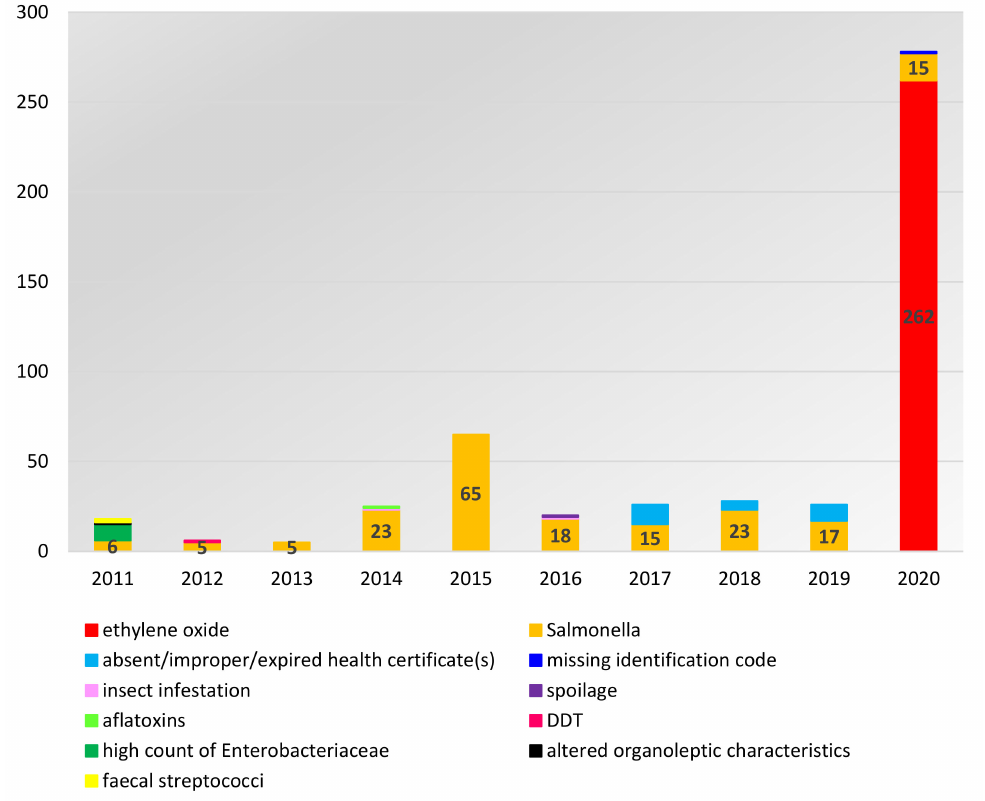
Figure 1. RASFF notifications linked to sesame seeds from India per substance/hazard over the period 1 January 2011–31 December 2020: the data broken down by year (Source: Own elaboration based on